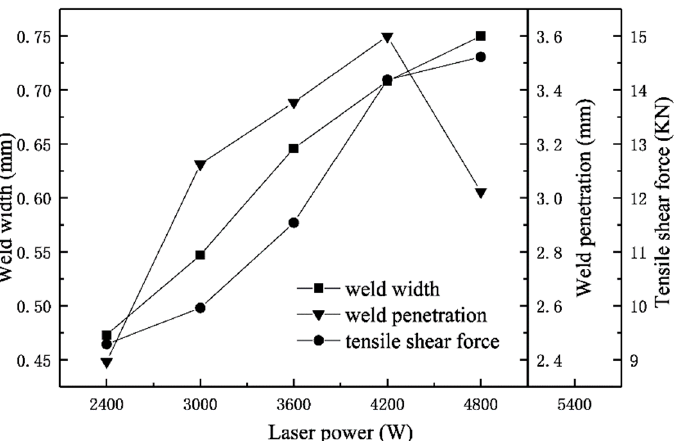
Figure 12. The schematic diagram of weld penetration, weld width and tensile-shear force changes at different laser powers.